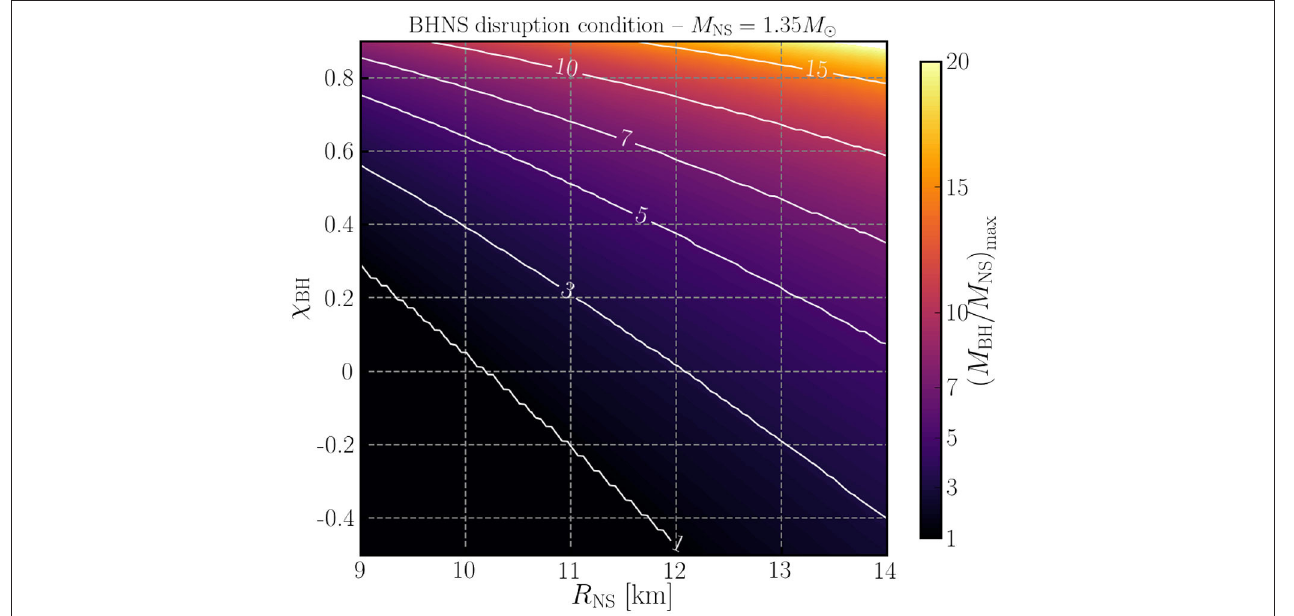
FIGURE 2 | Maximum value of the mass ratio M BH / M NS for which a BHNS system will disrupt as a function of the neutron star radius R NS and aligned component of the dimensionless black hole spin χ BH , assuming M NS = 1.35 M ⊙ ( Foucart et al., 2018). Results for other M NS can be obtained by looking at the disruption condition at constant C NS = GM NS / ( R NS c 2